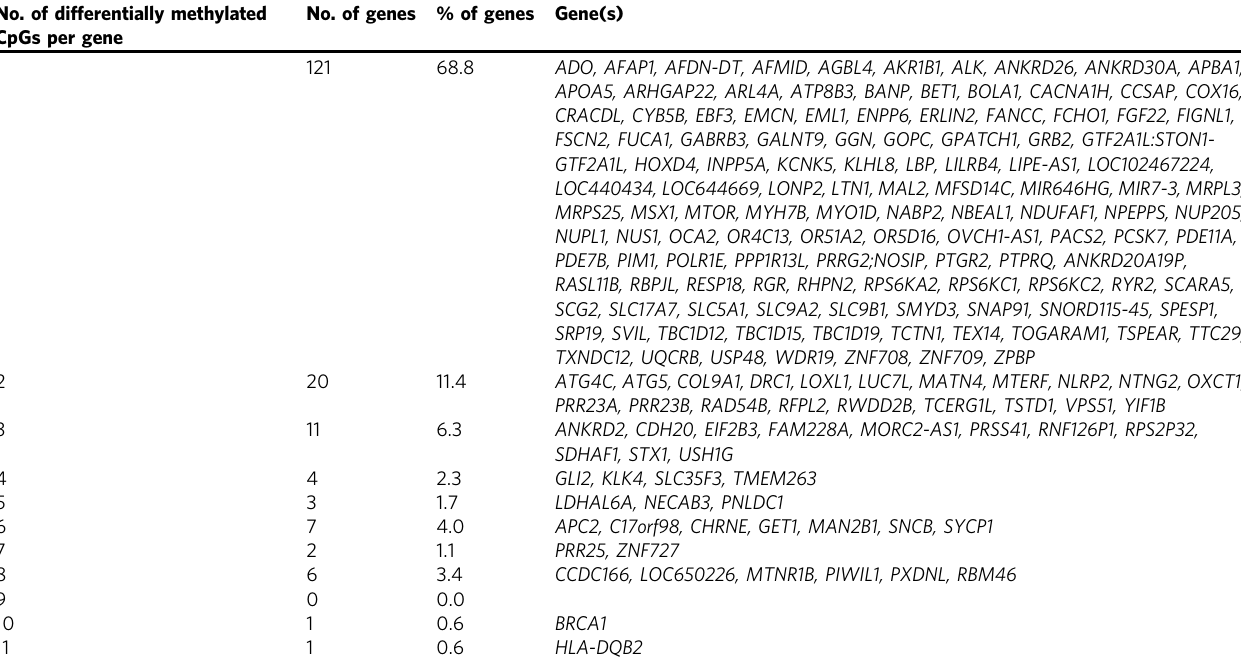
Table 2 Number of differentially methylated CpGs in 176 genes with signi fi cant differences between ART conceived and naturally conceived